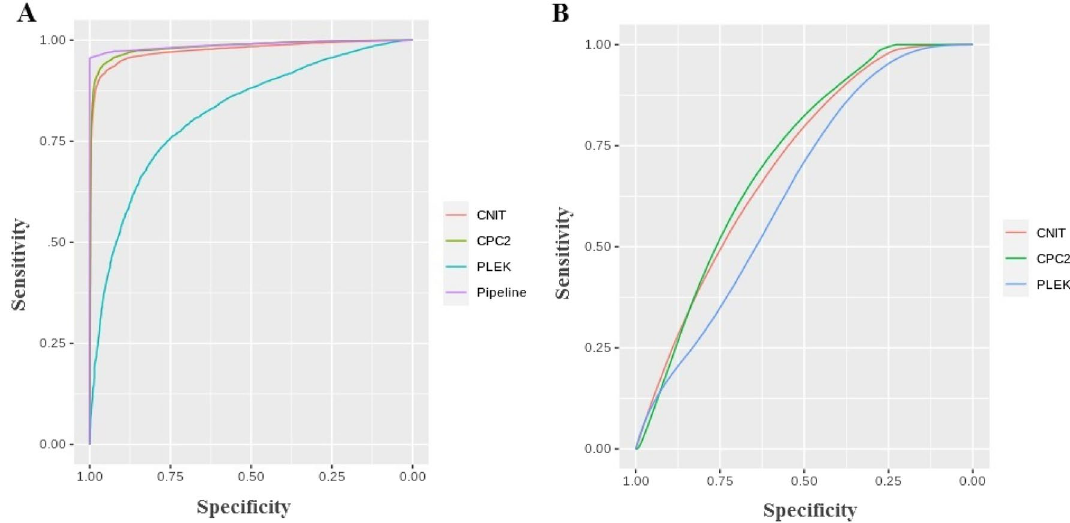
Figure 6. Sensitivity and specificity comparison of ECF pipeline with software programs (CNIT, CPC2 and PLEK) on: ( A ) Drosophila melanogaster datasets ( B ) Androctonus crassicauda RNA-seq datasets. The Area Under the Curve (AUC) measures the performance of an algorithm under different